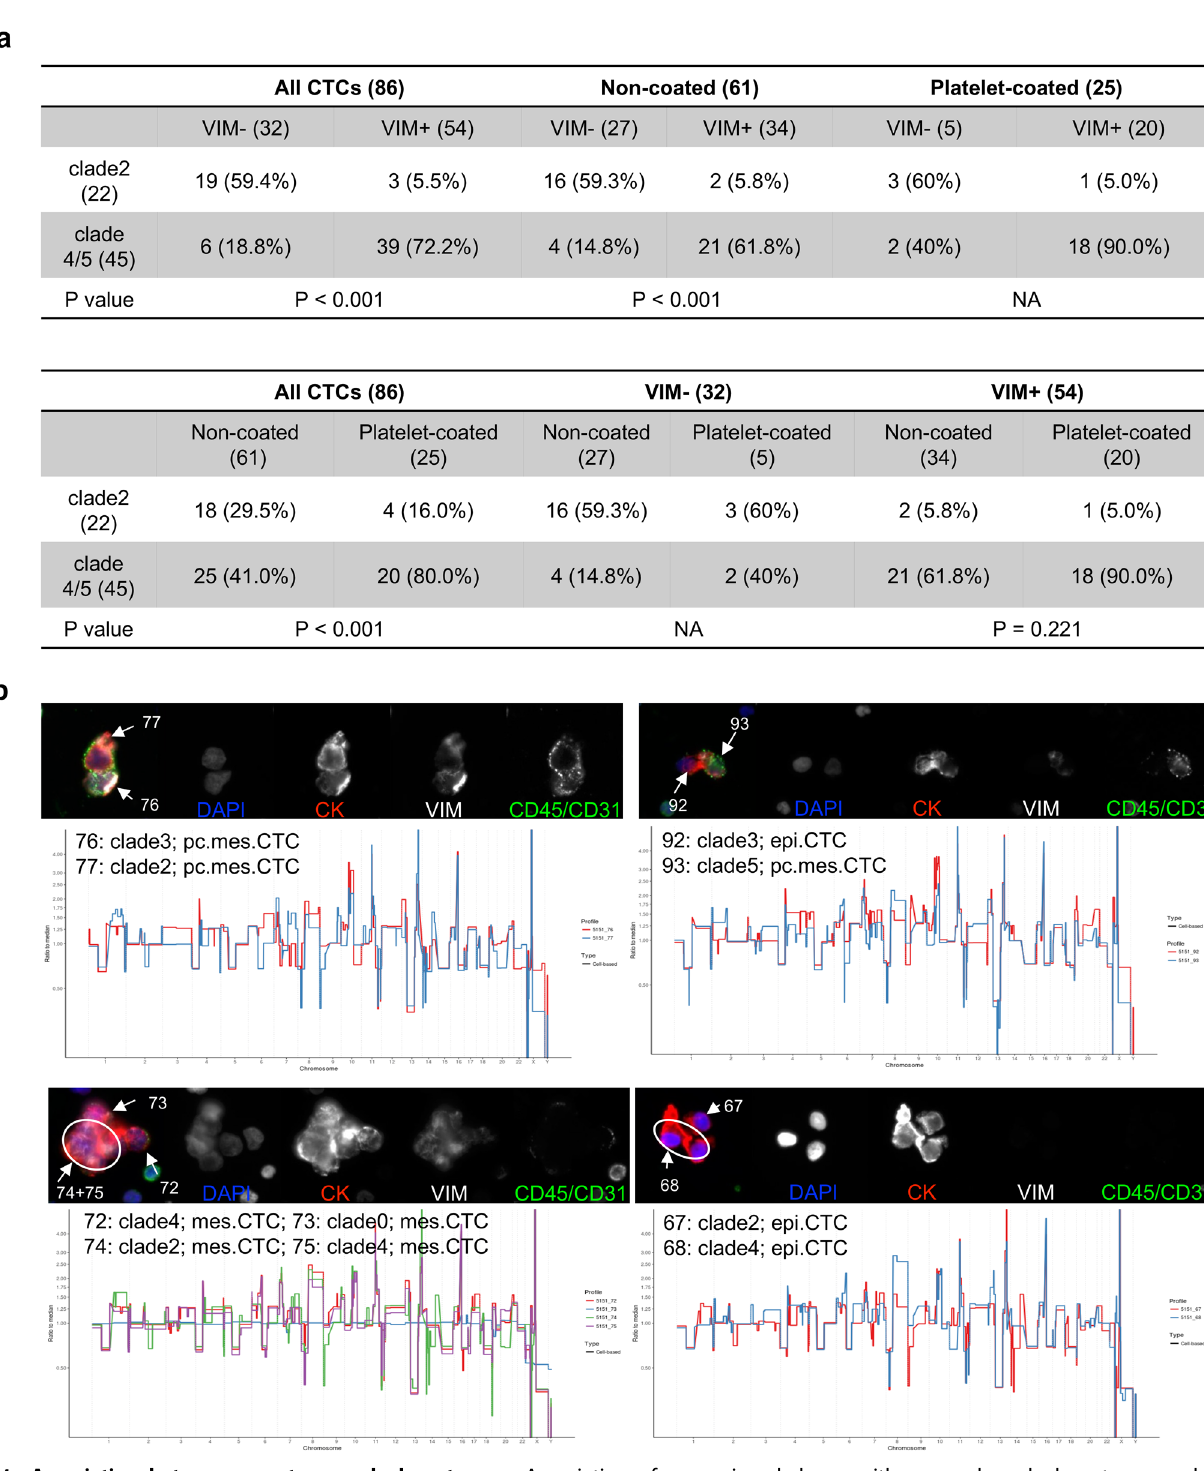
Fig. 4 Association between genotype and phenotype. a Association of genomic subclones with mesenchymal phenotype or platelet attachment in all CTCs or subpopulations. b Immuno fl uorescence images and single cell copy number pro fi les of representative heterogeneous CTC clusters in the BMA sample. Images order: composite, DAPI, CK, VIM, and CD45/CD31. The number is the sequencing cell